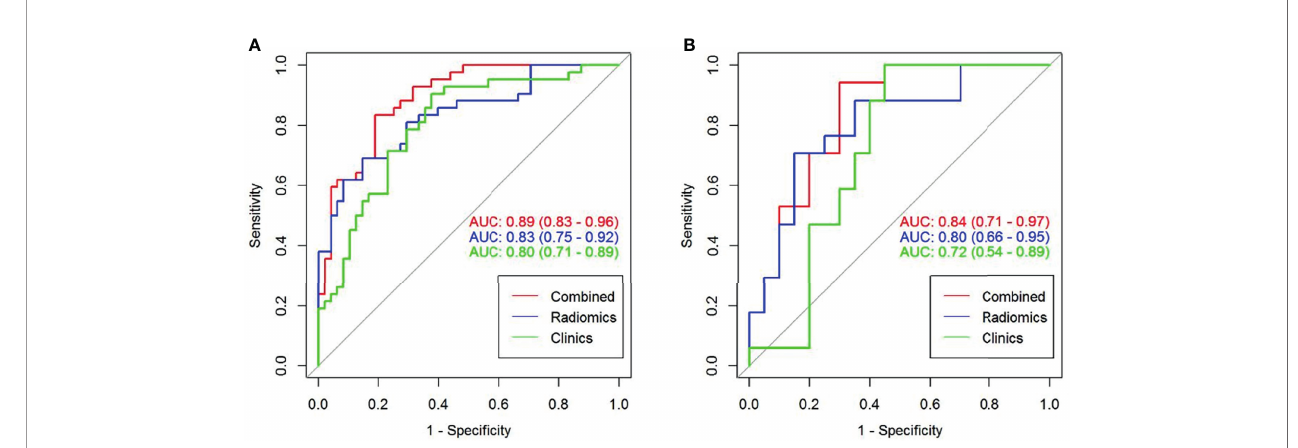
FIGURE 5 | The ROC curves (AUC) of the three models in the training (A) and testing sets (B) .